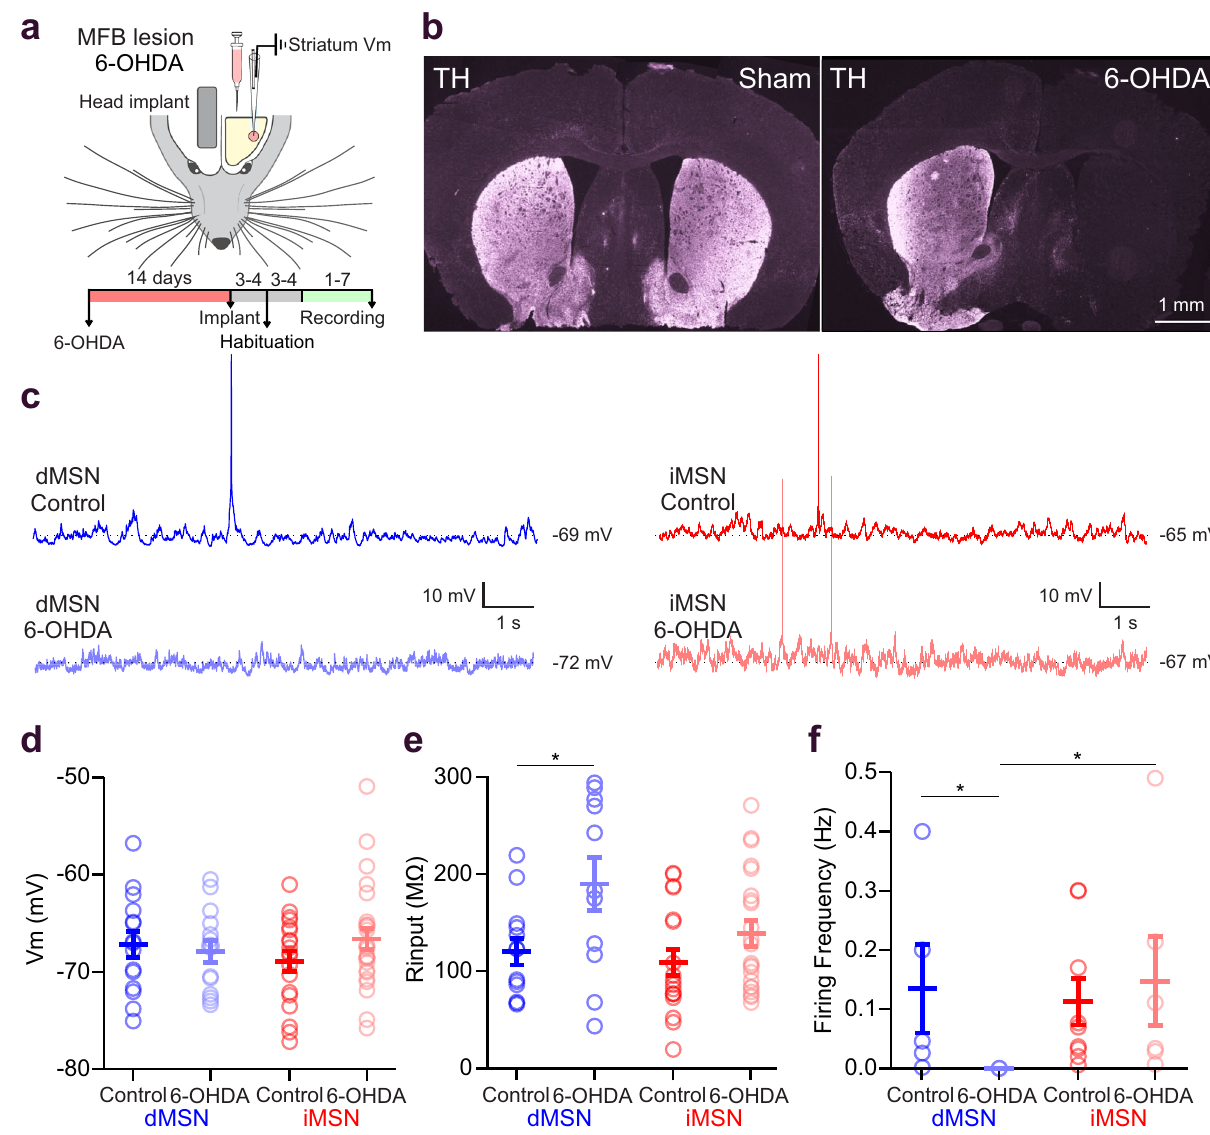
Fig. 2 | Membrane properties of MSNs in control and 6-OHDA lesioned mice. a Schematic of the experimental setup for whole-cell recordings in dopamine- depleted mice and the timeline of the 6-OHDA lesion. b Coronal sections showing the striatal hemispheres of sham (left) and 6-OHDA lesioned (right) mice, stained for TH expression. Fluorescence was strongly reduced in the 6-OHDA lesioned hemisphere ( n =12 mice) compared to the control hemispheres. c Example traces showing spontaneous membrane potential activity in dMSNs (blue) and iMSNs (red) under control conditions (dark color) and in 6-OHDA lesioned mice (light color). d No differences were observed in the membrane potential (Vm) of dMSNs andiMSNsincontroland6-OHDAlesionedmice(dMSNcontrol= − 67.18±1.30mV, n =15 cells; dMSN 6-OHDA= − 67.89±1.15mV, n =14 cells; iMSN control= − 68.90 ±1.05mV, n =19cells;iMSN6-OHDA= − 66.62±1.10mV, n =25cells, P >0.05forall comparisons, one way ANOVA, Tukey multiple comparison test between groups, F =0.813, P =0.491). e The input resistances (R input) of dMSNs and iMSNs were similar in control conditions (dMSN control=120.10±13.59M Ω , n =13 cells; iMSN control=114.49±12.92 M Ω , n =17 cells; P =0.995). Following DA depletion, input resistance increased in dMSNs but not iMSNs (dMSN control vs. dMSN 6-OHDA=